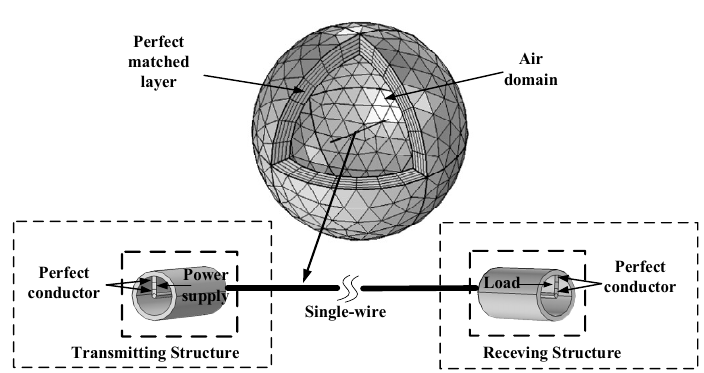
Figure 5. Simulation model of one-way single-wire power transfer system.